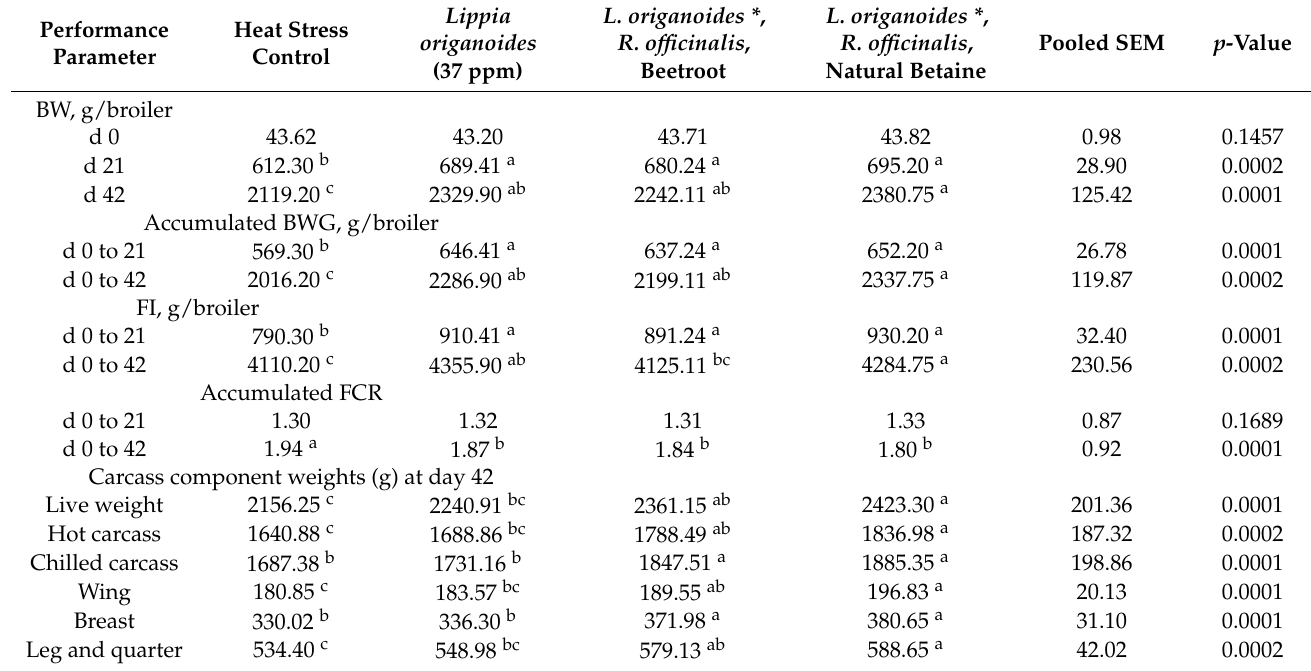
Table 2. Evaluation of essential oils on broiler chickens exposed to cyclic heat stress on performance parameters and carcass component weights at days 21 and 42.